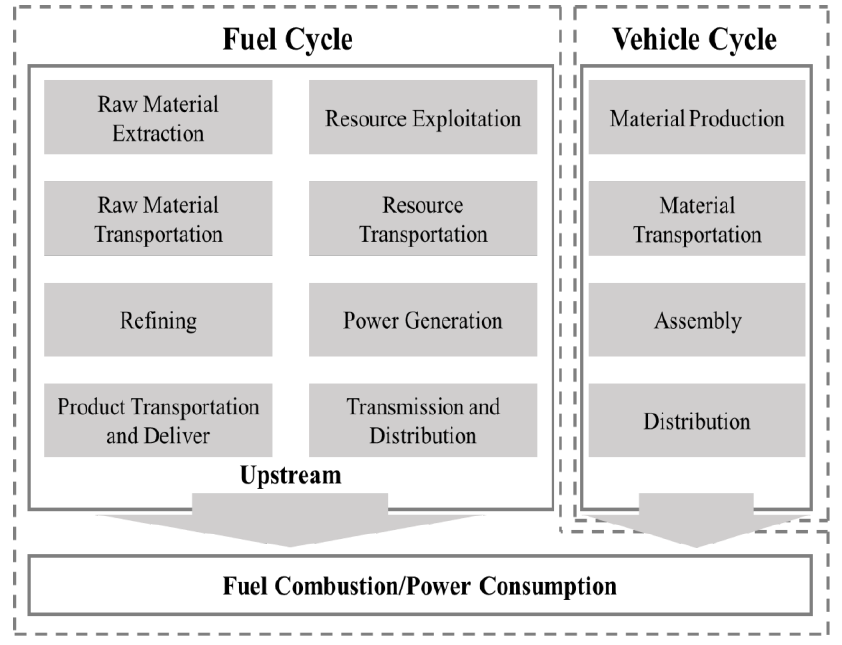
Figure 2. Research framework.